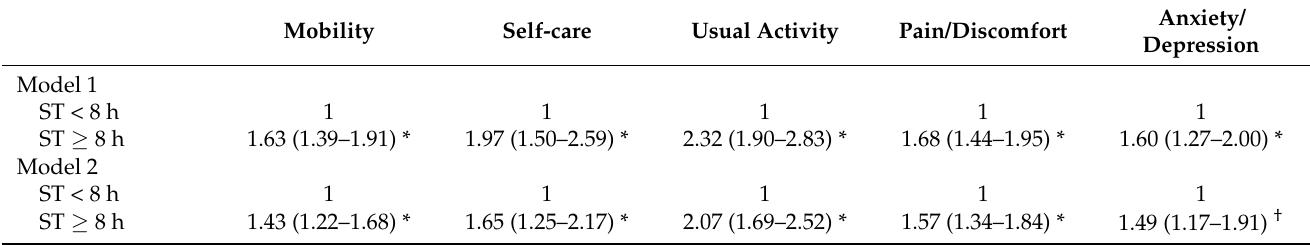
Table 2. Association between sitting time and each EQ-5D dimension.